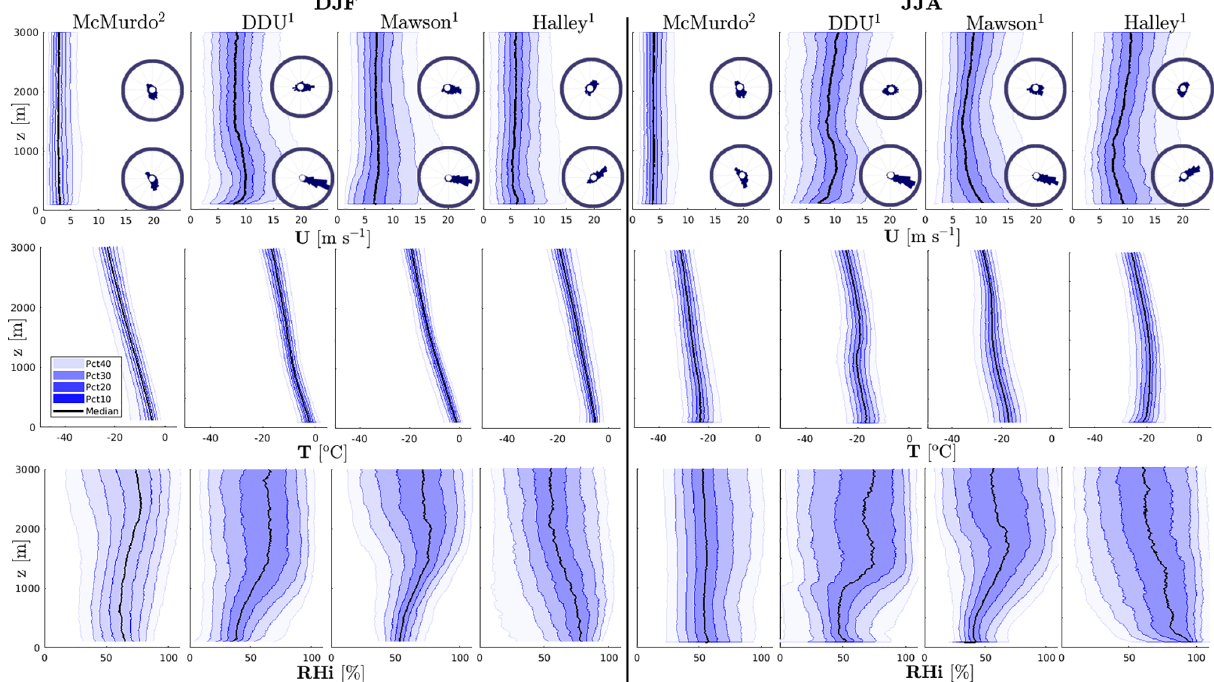
Figure 3. DJF (left panels) and JJA (right panels) vertical profiles of the of the wind speed (top row), temperature (middle row) and relative humidity with respect to ice (bottom row) from radiosonde measurements at four Antarctic stations. Black lines are the medians, colored shadings refer to the 10th, 20th, 30th, 40th, 60th, 70th, 80th and 90th percentiles. In the legend, “Pct x ” refers to the shaded area that covers x percent of the data greater than the median and x percent of the data lower than it. The altitude z is above ground level. Wind roses at z = 500 and at z = 2000m are also plotted in the top row panels. Numbers in exponential form next to station names in the title indicate the number of radiosoundings per day at the corresponding station.